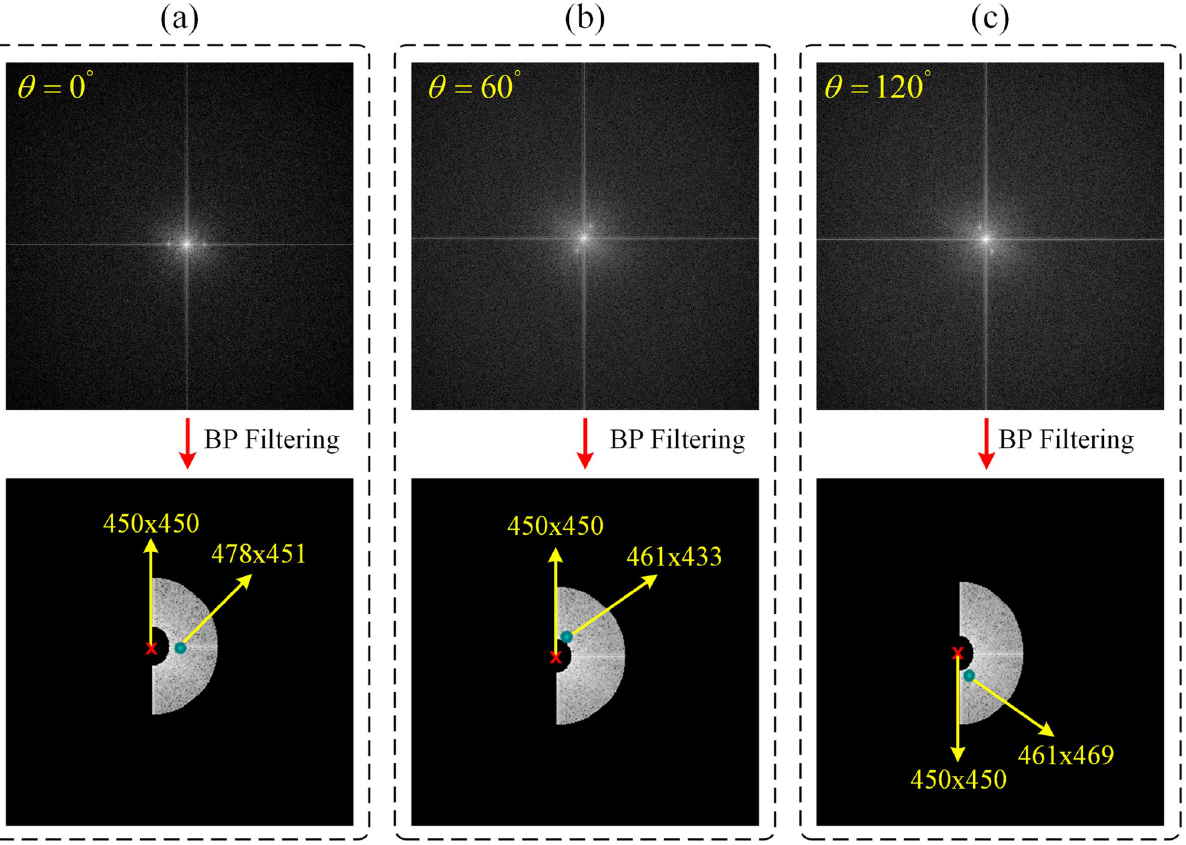
Fig 4. 2D spatial frequency spectra of raw images obtained with DMD patterns generated with φ = 120˚ and different θ values of 0˚, 60˚, and 120˚ are shown in (a), (b), and (c), respectively. Second row shows the same 2D spatial frequency spectra after band-pass filtering. Peak finder algorithm reveals experimental φ and θ values of ( θ = − 2.04˚, φ = − 21.6˚), ( θ = 57.09˚, φ = 144.19˚), ( θ = − 120.06˚, φ = 75.3˚) for (a), (b), and (c), respectively.